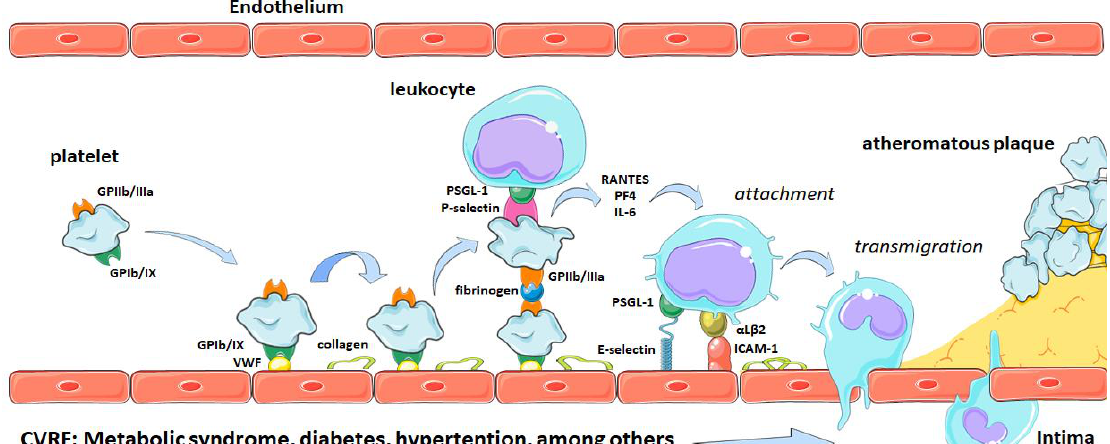
Figure 2. Participation of platelets in the atherothrombotic process. VWF, von Willebrand factor; GP, glycoprotein; IL, interleukin, PF4, platelet factor 4; PSGL-1, glycoprotein ligand-1 P-selectin; RANTES, beta-regulatory chemokine; VCAM-1, vascular cell-1 adhesion molecule.